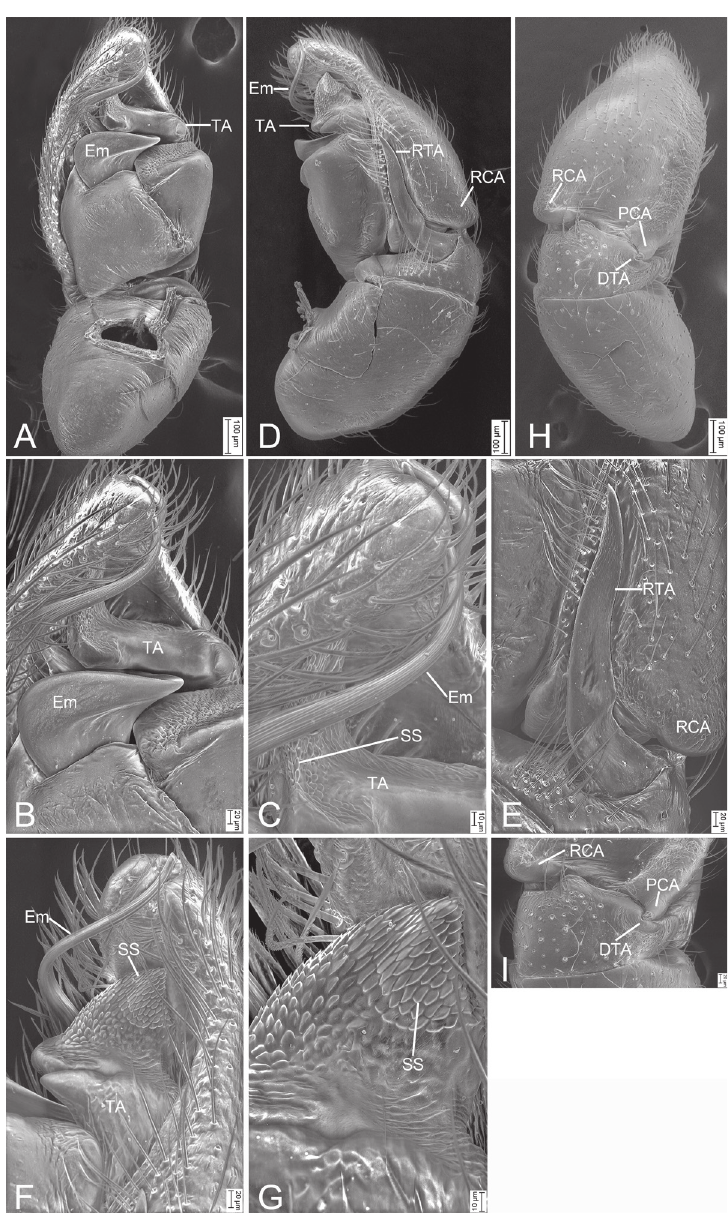
Figure 10. Synagelides shuqiang sp. nov., SEMs of holotype male A palp, ventral view B same, detail of terminal apophysis and embolus, ventral view C same, detail of terminal apophysis and embolus, ventral view D same, retrolateral view E same, detail of retrolateral tibial apophysis, retrolateral view F same, de- tail of terminal apophysis and embolus, retrolateral view G same, detail of terminal apophysis, retrolateral view H same, dorsal view I same, detail of postero-prolateral cymbial apophysis, postero-retrolateral cym- bial apophysis and dorso-prolateral tibial apophysis, dorsal view. Abbreviations: DTA – dorso-prolateral tibial apophysis, Em – embolus, PCA – postero-prolateral cymbial apophysis, RCA – postero-retrolateral cymbial apophysis, RTA – retrolateral tibial apophysis, SS – scale-like serrations, TA – terminal